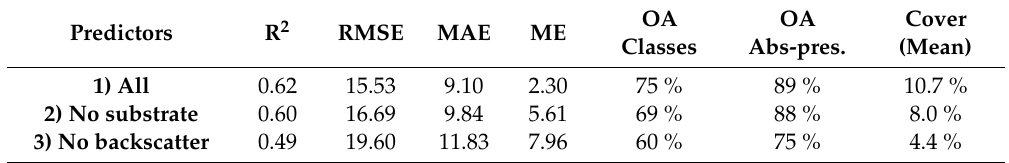
Table 8. Accuracy table and mean percent cover for Mytilus spp. models with di ff erent predictor variables. Accuracy was measured (testing data, observed vs. predicted) with R 2 , root mean square error (RMSE), mean absolute error (MAE) and mean error (ME). In addition, the predicted values were grouped into intervals (0–10%, 10–50%, 50–90%, 90–100%) and evaluated with overall accuracy (OA)